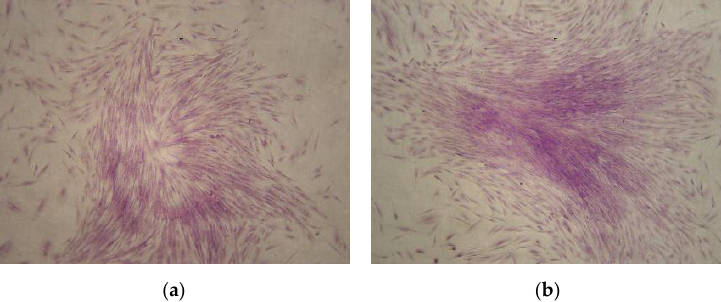
Figure 2. ( a , b ) Colony-forming unit fibroblast (CFU-F) colonies formation from CMSCs after passage 1 with Romanowsky–Giemsa staining (10× magnification of objective).